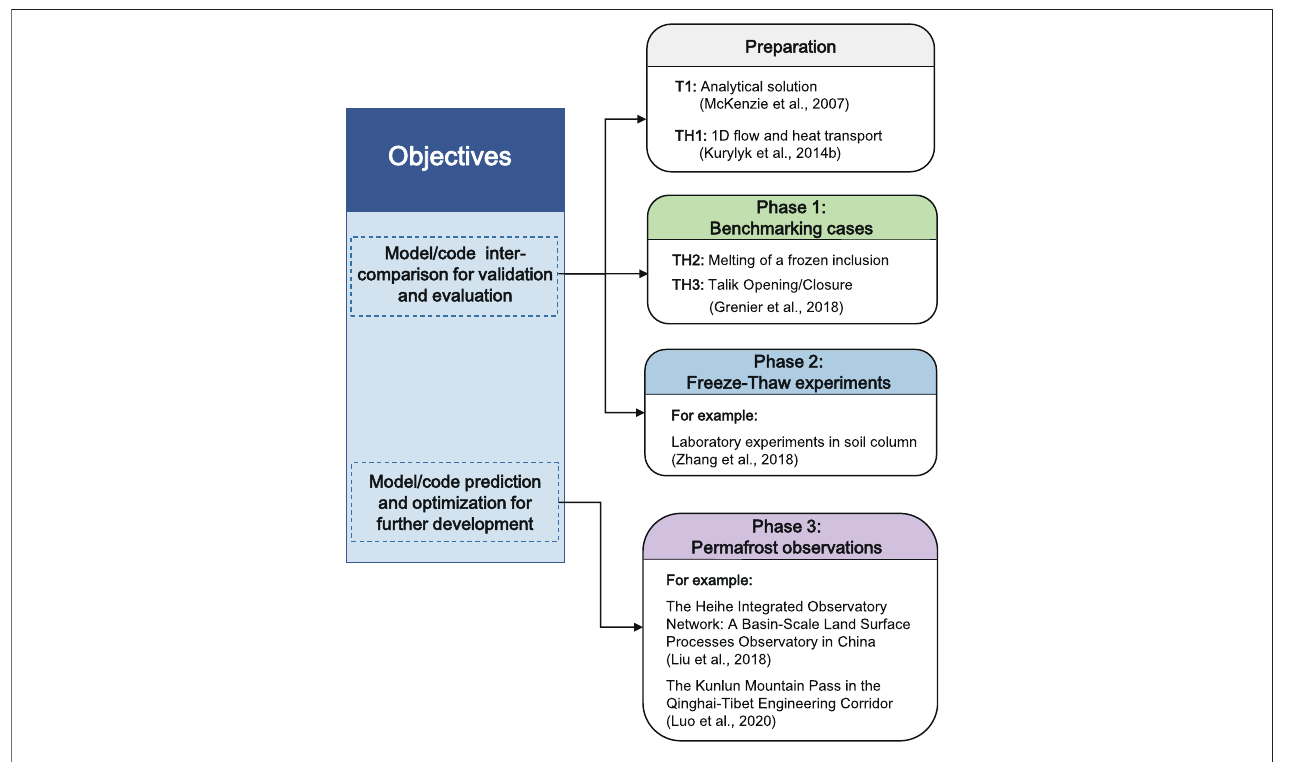
FIGURE 3 | The fl owchart and examples of cold region hydrologic model